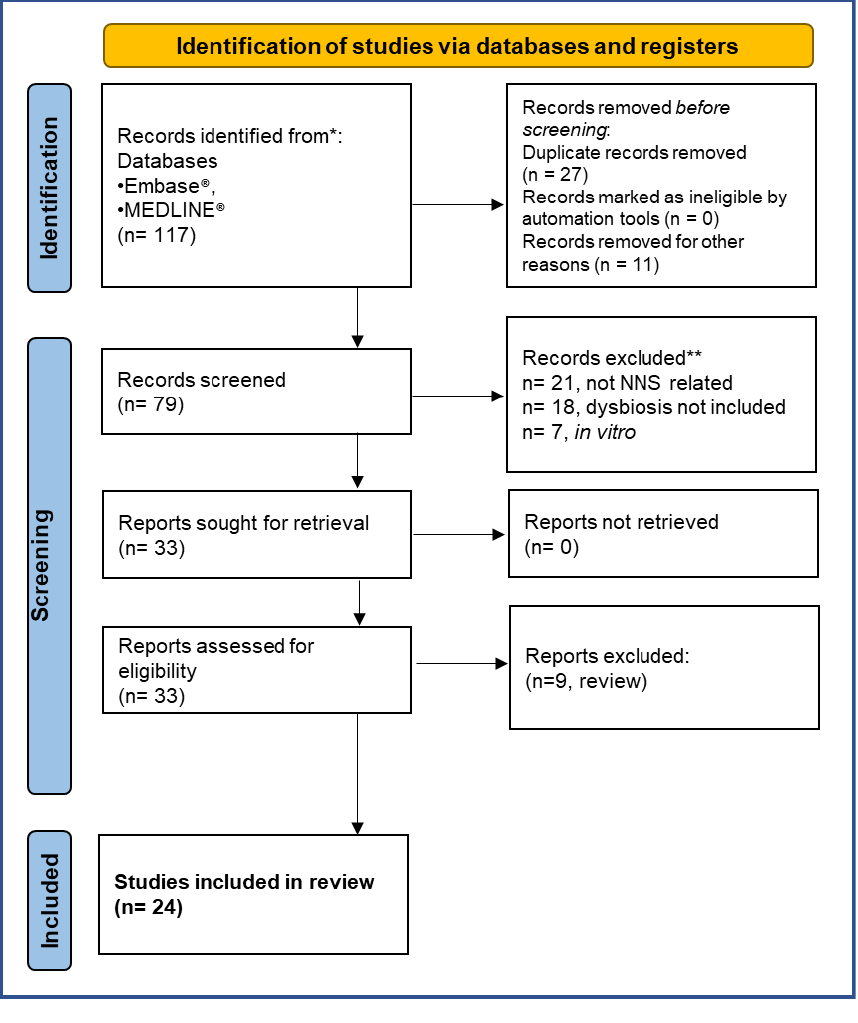
Figure 3. PRISMA 2020 flow diagram for new systematic reviews including searches of databases and registers only. * The number of records identified from each database or register searched (rather than the total number across all databases/registers). ** Records excluded by the researchers.